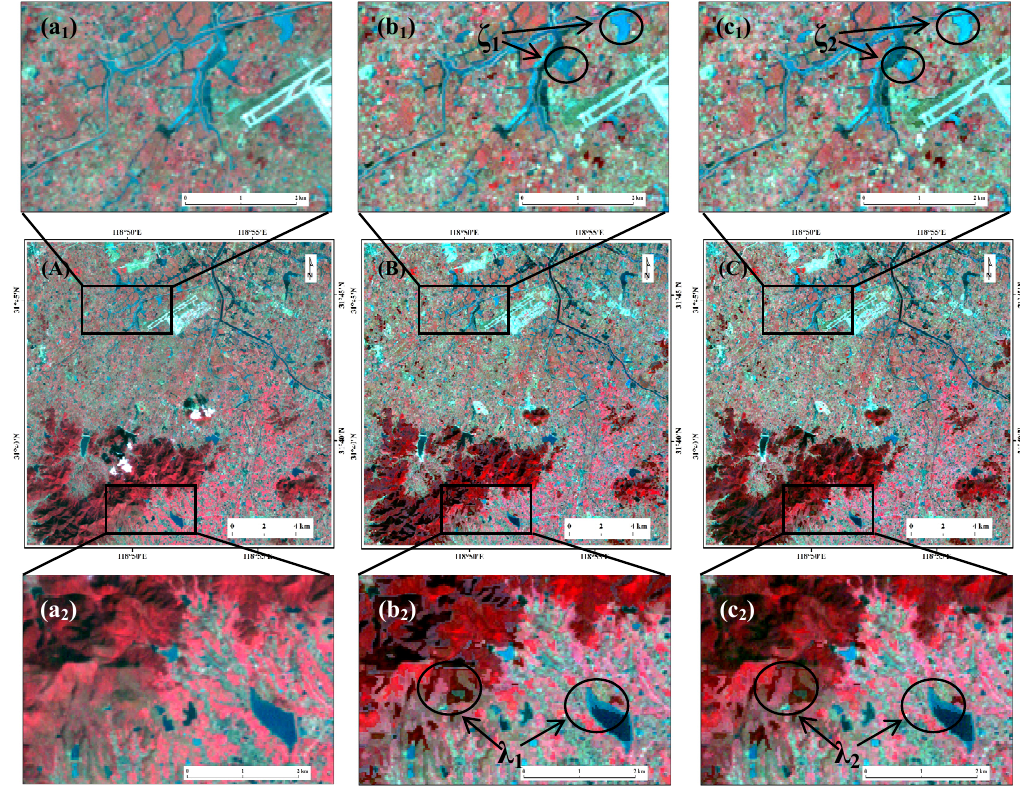
Figure 6. Comparisons between the actual image on 24 October 2002 ( A ) and the predicted image by ESTDFM ( B ), the predicted image by STDFM ( C ) (all images are NIR-red-green – c ) and ( a – c ) are the partial enlarged details of (A–C). composites). ( a 1 1 2 2